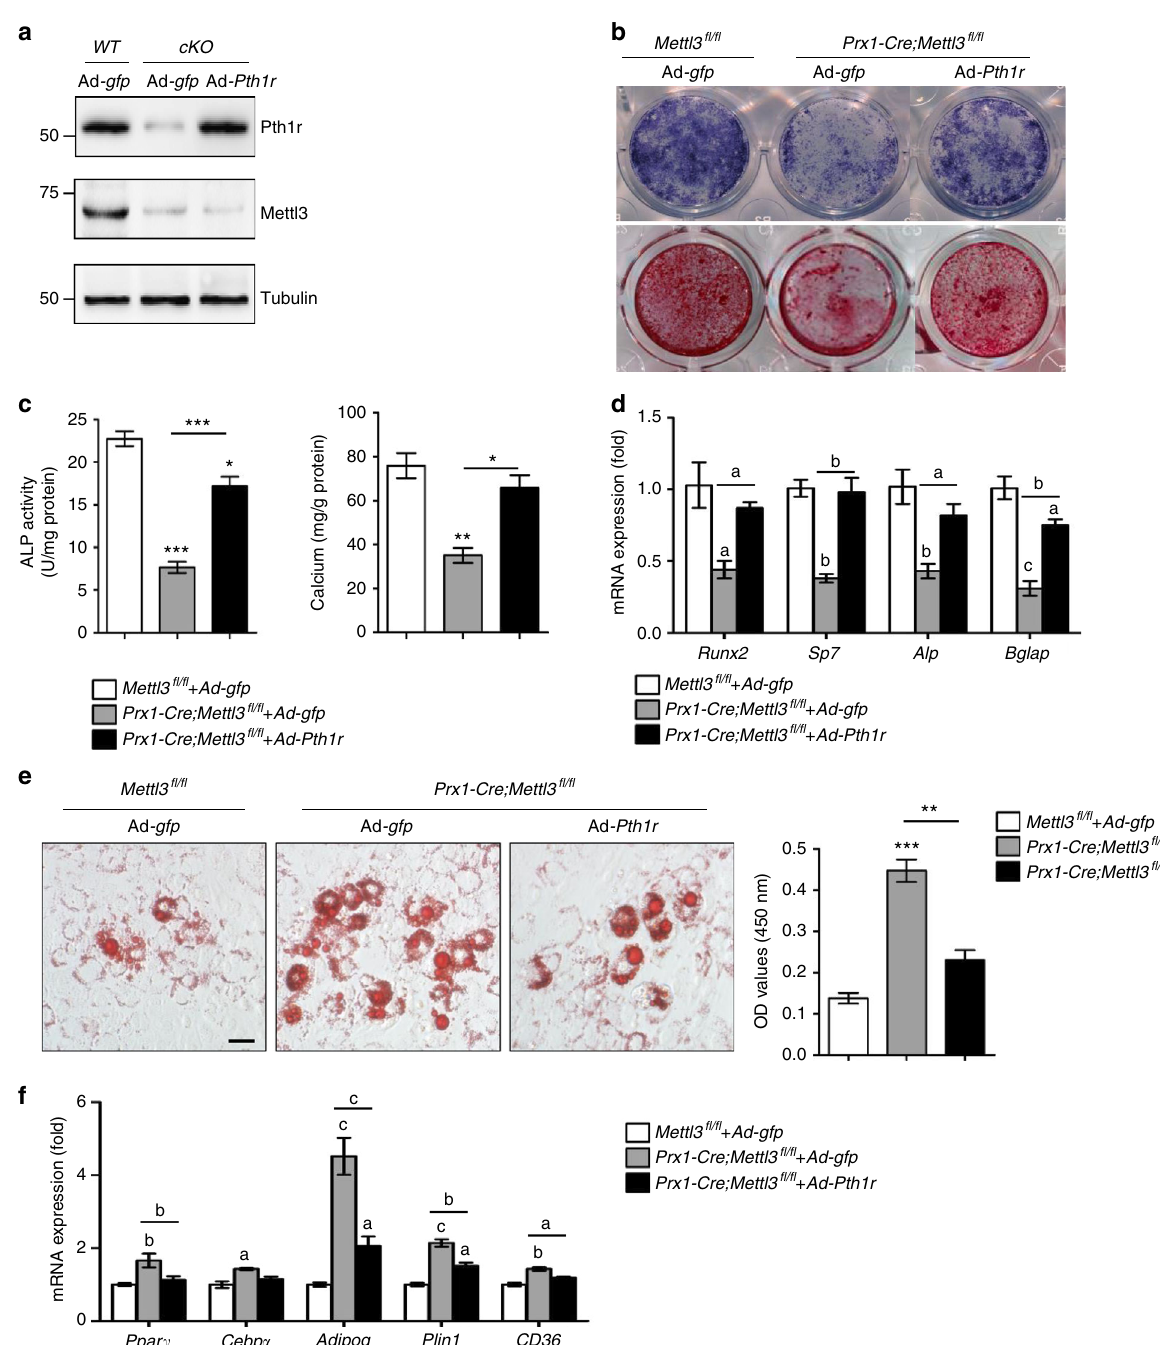
Fig. 7 Overexpression of Pth1r ameliorates osteogenic differentiation of Mettl3 -de fi cient MSCs. a Western blot analysis of Pth1r and Mettl3. WT : Mettl3 fl / fl , cKO : Prx1-Cre;Mettl3 fl / fl . b , c Representative images and quantitative analyses of ALP and ARS staining. d qRT-PCR analyses of the expression of Runx2 , Sp7 , Alp , and Bglap under osteogenic condition. e Representative images and quantitative analysis of oil red O staining. Scale bar, 100 μ m. f qRT-PCR analyses of the expression of Cebp α , Ppar γ , Adipoq, Plin1 and CD36 under adipogenic condition. Results are from three independent experiments. Data are expressed as mean ± s.e.m.; * P < 0.05, ** P < 0.01, *** P < 0.001 ( c , e ) and a: P < 0.05, b: P < 0.01, c: P < 0.001 ( d , f ) by one-way ANOVA with Tukey ’ s post hoc